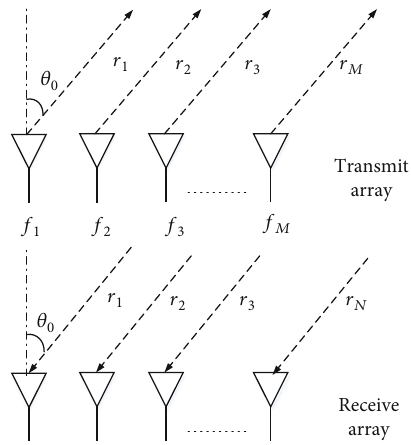
Figure 1: The conventional con fi guration of